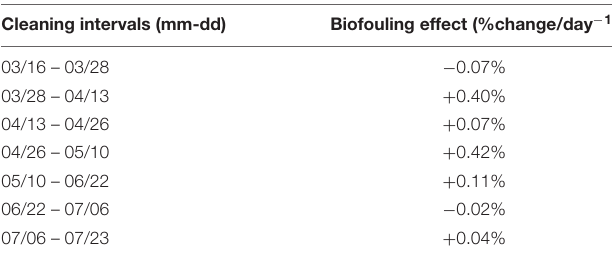
TABLE 1 | Estimated maximum biofouling effect (%change/day) across the study period calculated as the difference in measured fluorescence of a standard solution before and after the WET Labs ECO Triplet fluorometer was